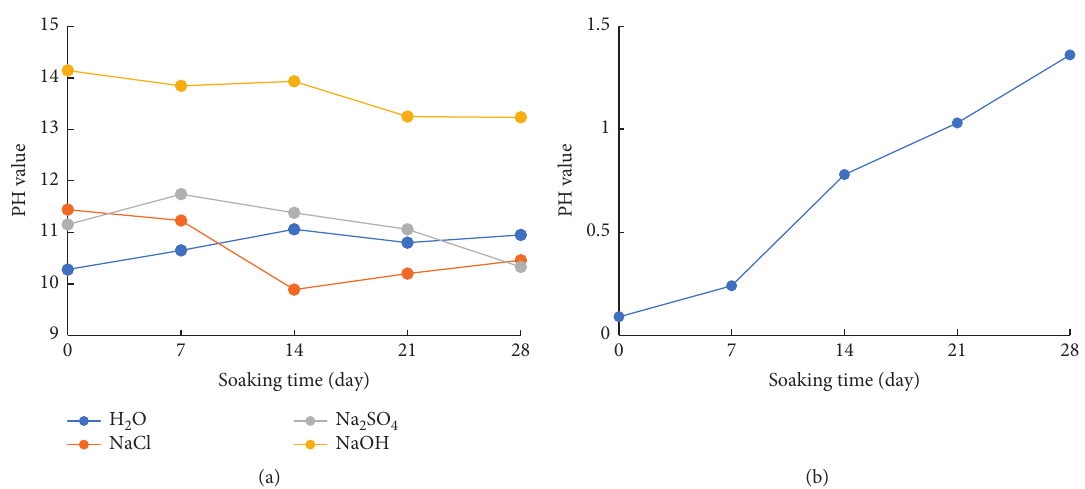
Figure 13: Erosion environment pH change. (a) pH change. (b) pH change of sulfuric acid solution.